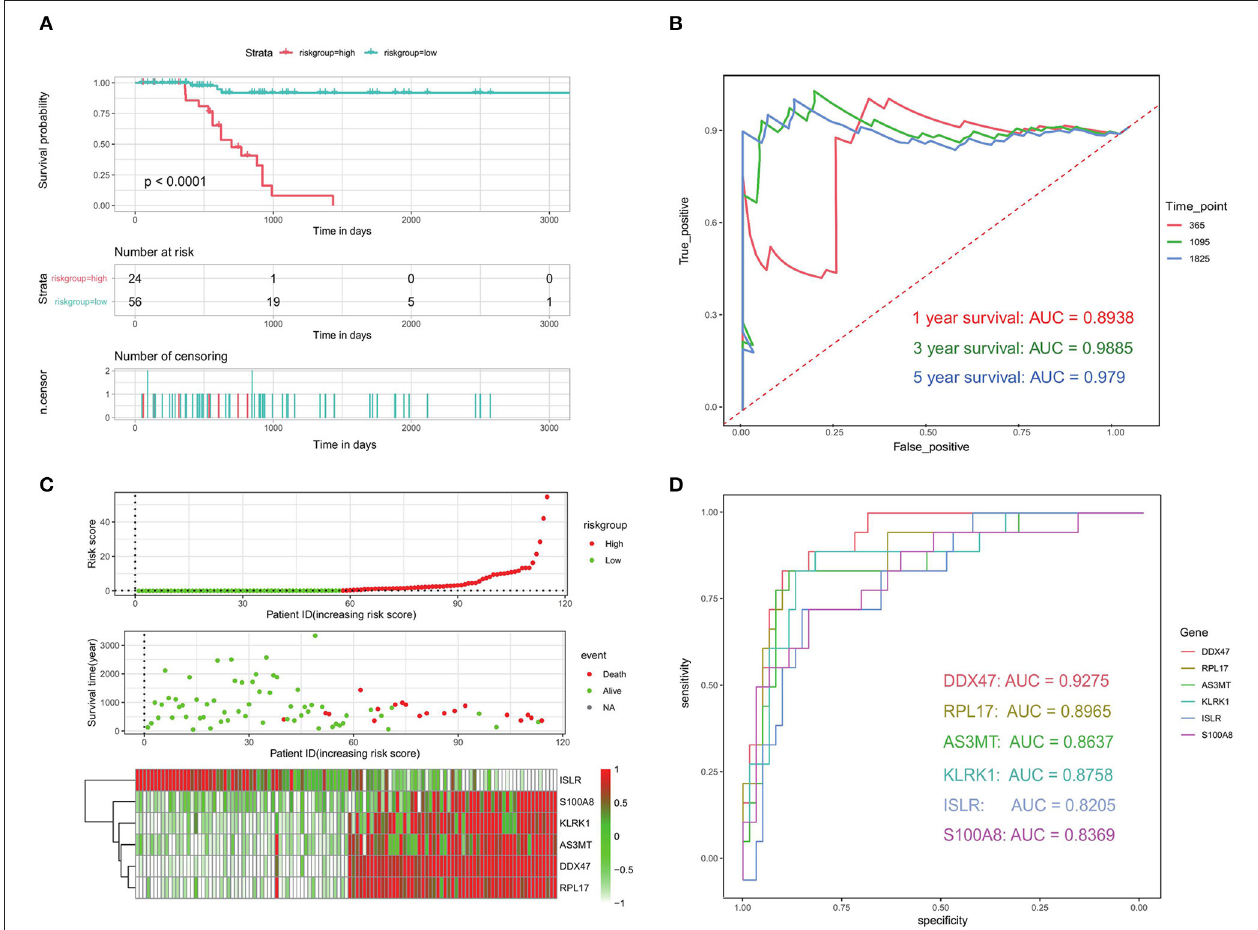
FIGURE 9 | Evaluation of prognostic models related to bone metastases. (A) Kaplan-Meier analysis of patients in the high- and low-risk groups. (B) ROC analysis of risk scores to assess sensitivity and specificity. (C) Risk factor analysis to assess the relationship among risk score, death, and characteristic gene expression. (D) ROC analysis of the six identified bone metastasis-associated prognostic